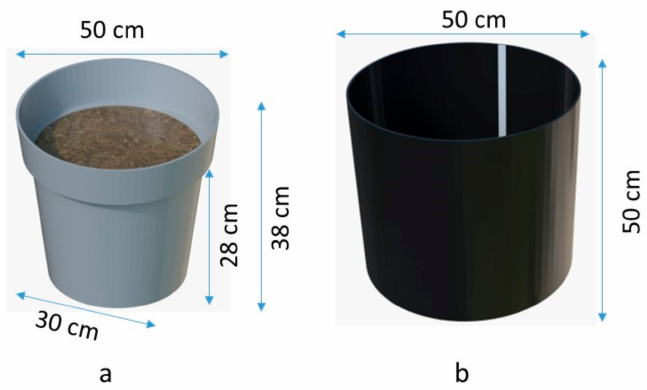
Figure 2. ( a ) The dimensions of pot; ( b ) the dimensions of pan evaporation.